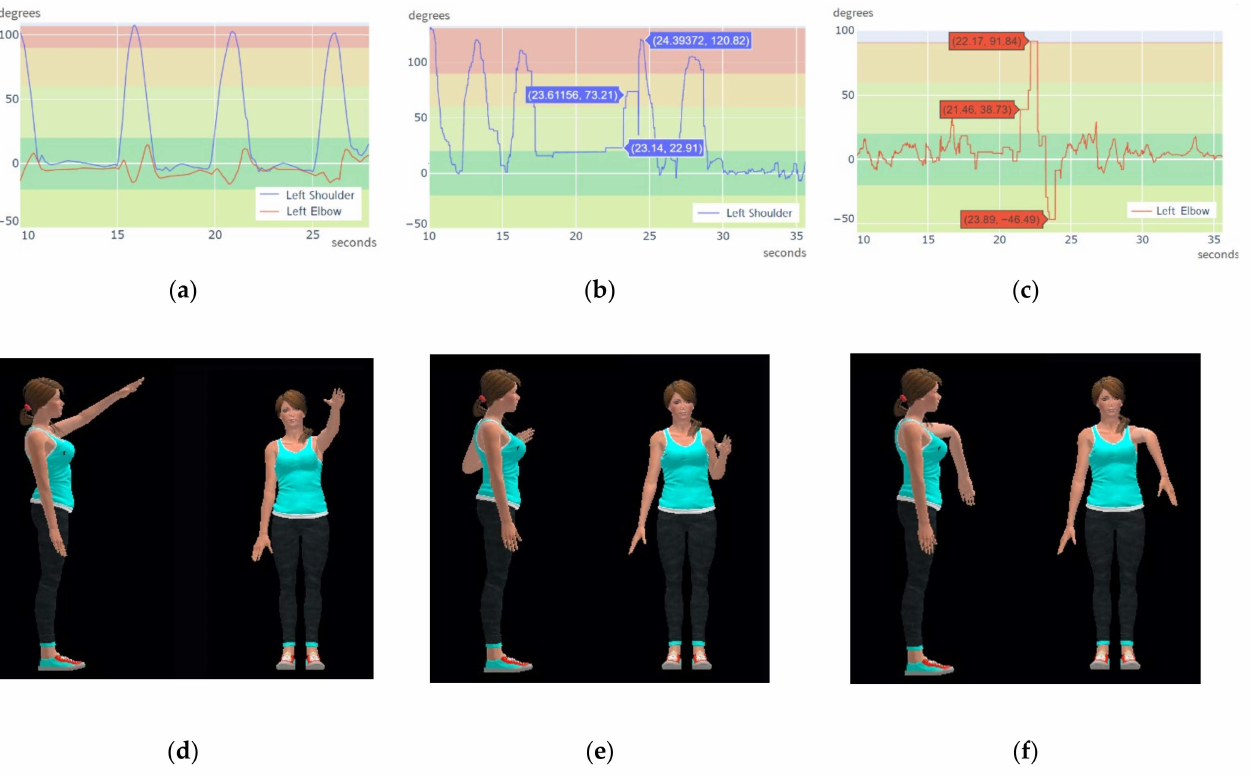
Figure 16. Shoulder and elbow joint angles in a 2.4 GHz crowded environment for frontal elevation of both arms: ( a ) Left shoulder and elbow flexion using CW data; ( b ) Left shoulder flexion using XDOT data; ( c ) Left elbow flexion using XDOT data. Movement reconstruction in 3D: ( d ) CW sensors; ( e ) XDOT sensors at second 22; ( f ) XDOT sensors at second